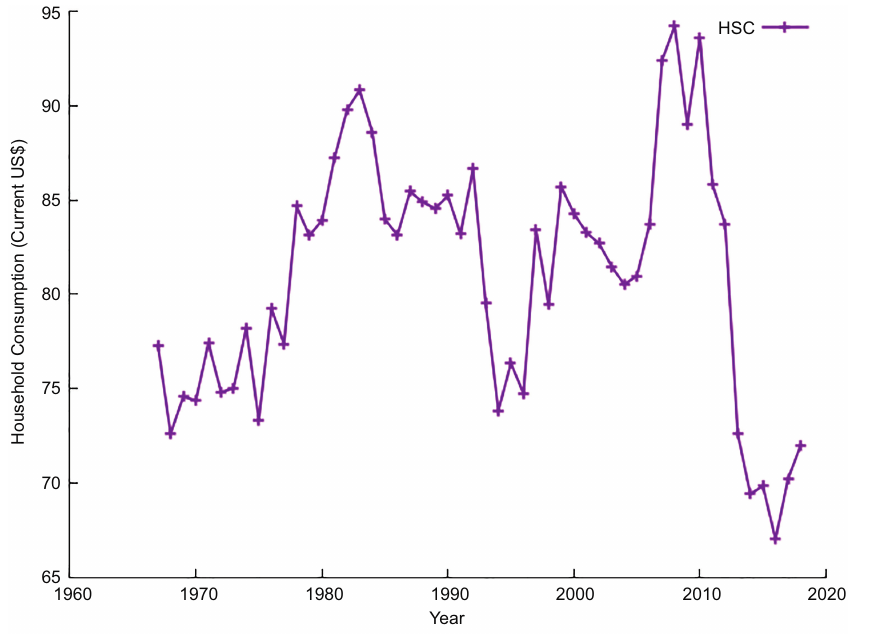
Figure 1. Trends in